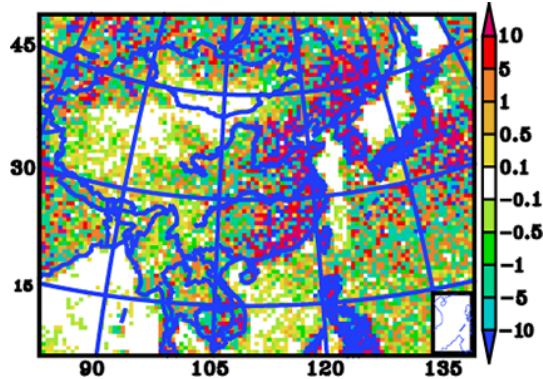
Figure 14. Monthly mean values of the difference between the prior true surface CO 2 fluxes and the ensemble mean values of the assim- ilated surface CO 2 fluxes (units: µmolem − 2 s − 1 ) of the reference experiment in which λ p were set to i,t | t − 1